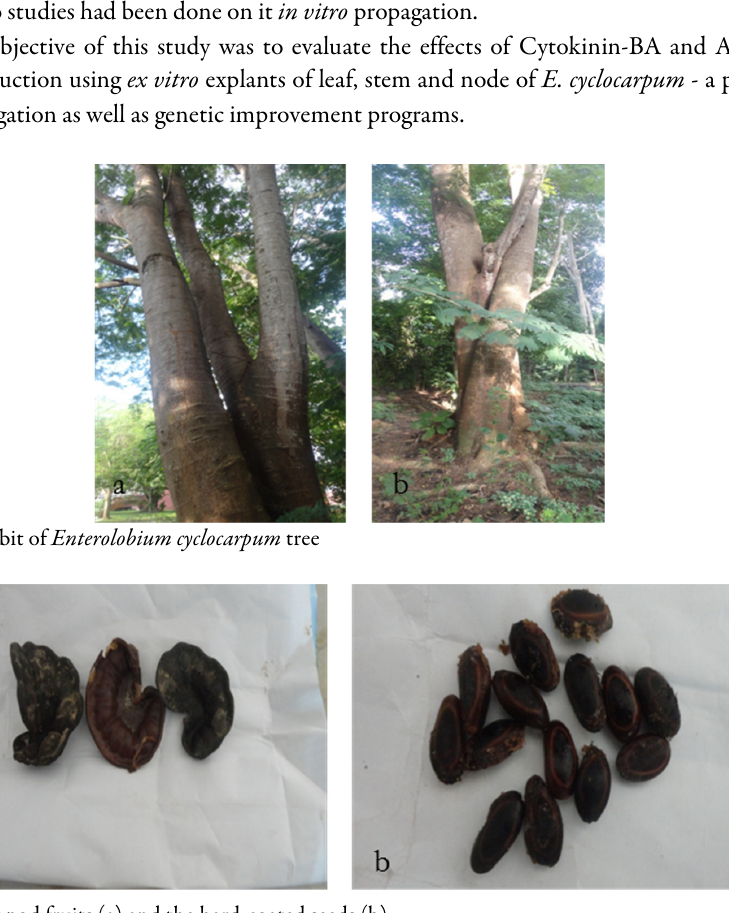
Figure 2. Ear pod fruits (a) and the hard-coated seeds